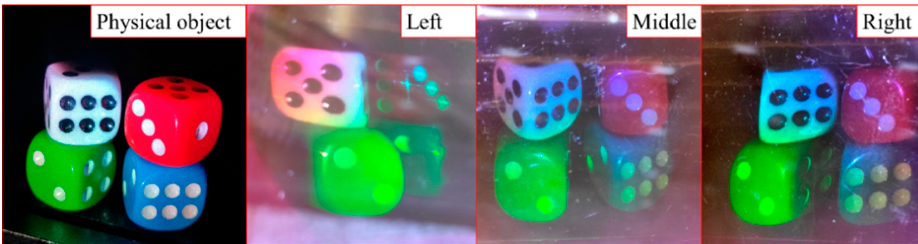
Figure 9. Volume holography-based RGB multiplexing full-color 3D display experimental results.